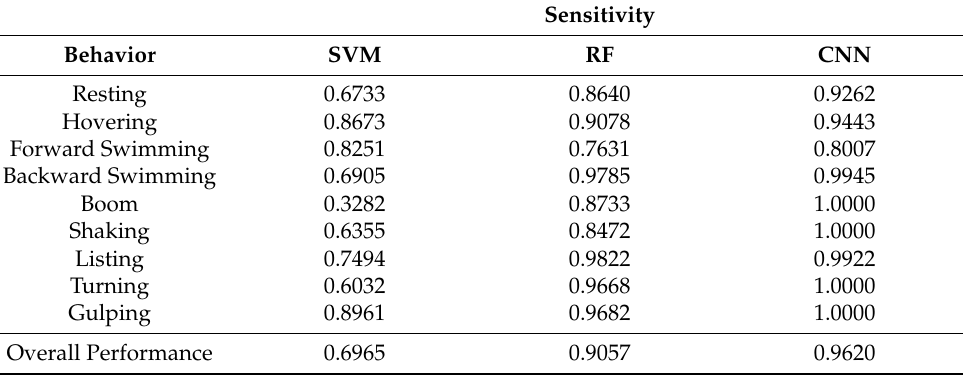
Table 5. Sensitivity results for the conventional machine learning approaches: support vector machine (SVM) and random forest (RF), and the deep learning approach: convolutional neural network